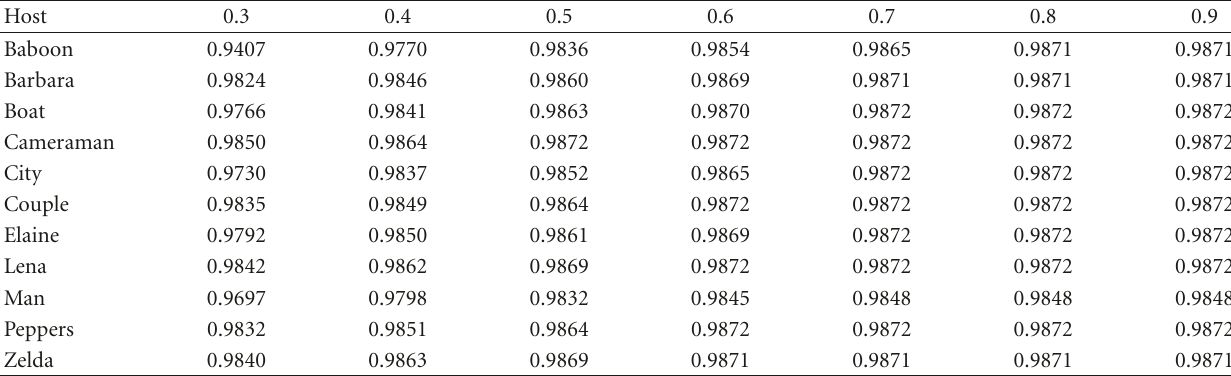
Table 5: Normalized correlation coe ffi cients after JPEG2000 compression on watermarked images in which the watermark is embedded in the 16th directional subband.